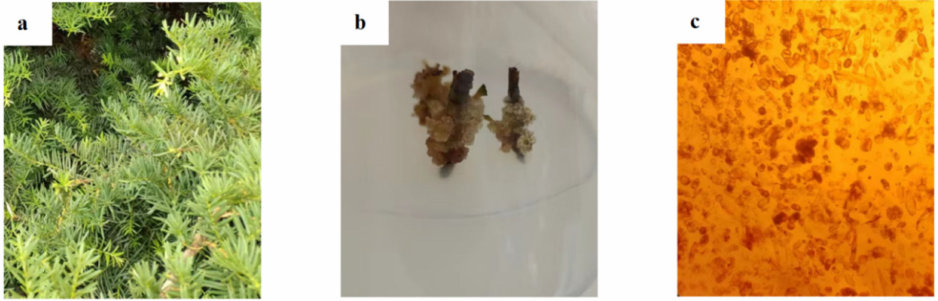
Figure 1. Growth state diagram of ( a ) needles, ( b ) callus, and ( c ) suspension cells of Taxus cuspidata